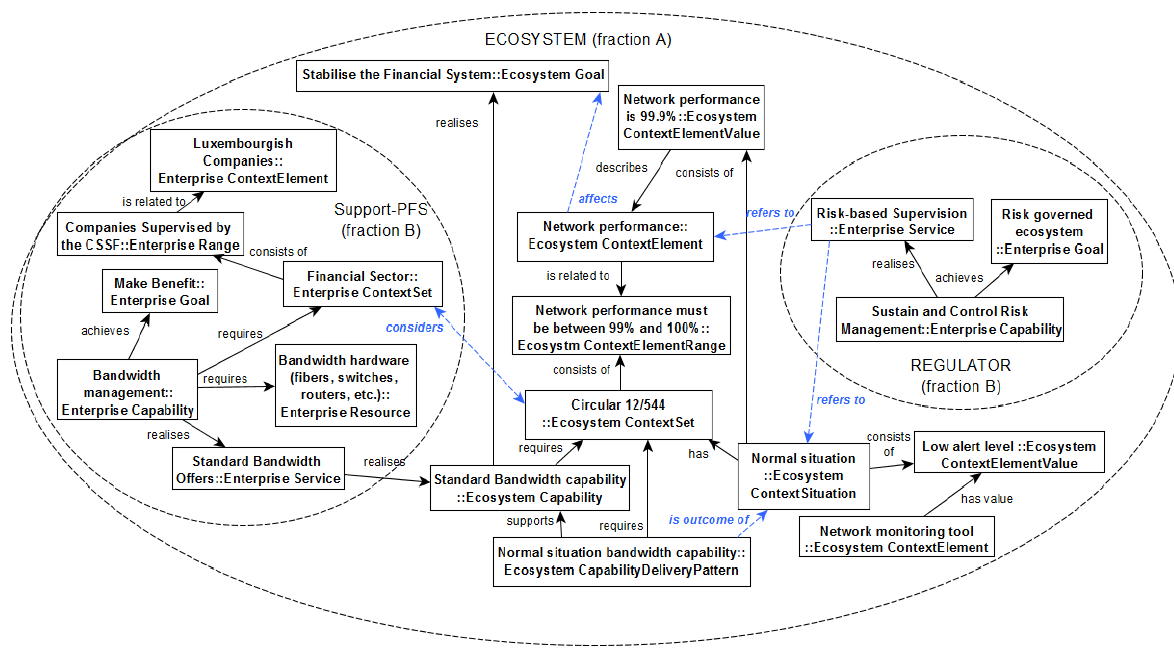
Figure 5. Business Service Ecosystem metamodel instantiated to the financial sector in case of normal